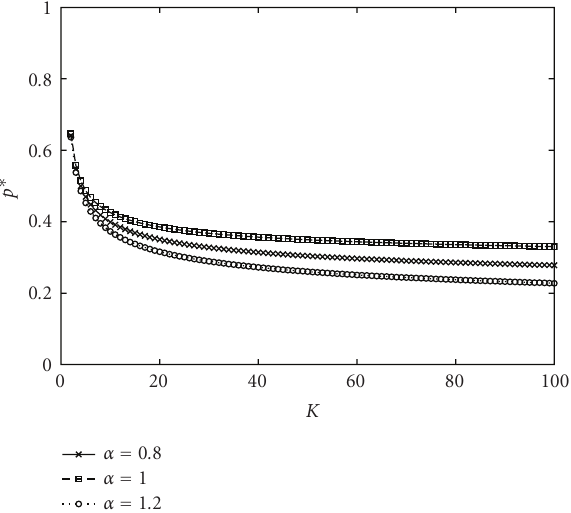
Figure 2: The equilibrium p ∗ as a function of K .